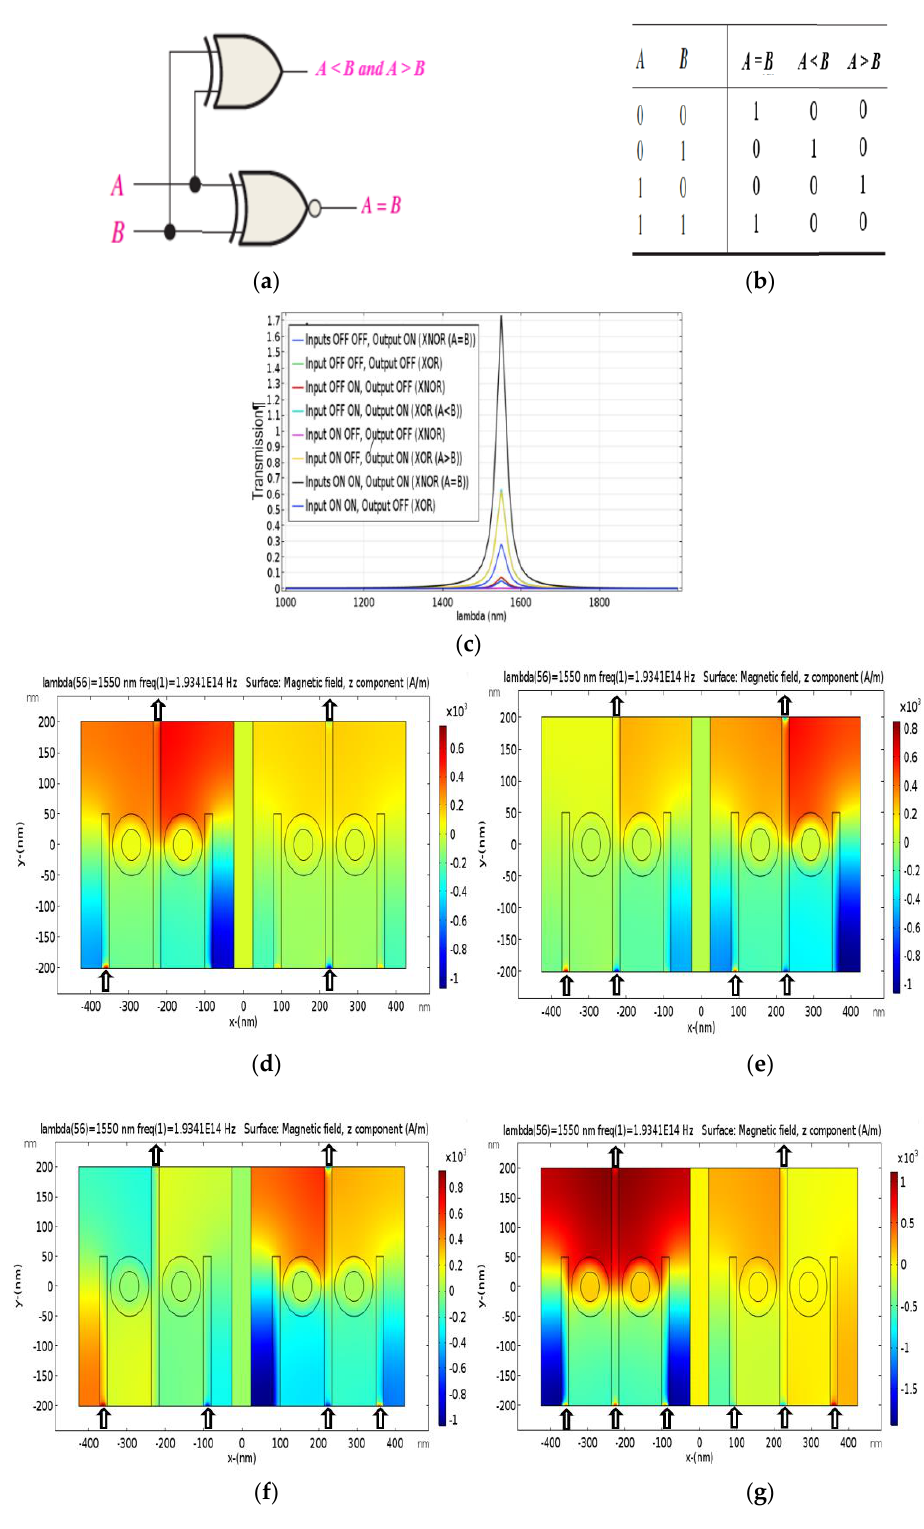
Figure 4. ( a ) and ( b ) the conventional comparator one-bit logic diagram and its truth table, respectively. ( c ) The transmission spectrum of the proposed plasmonic comparator one-bit for different states, according to its truth table. ( d ), ( e ), ( f ) and ( g ) the magnetic field distribution of Logic 00, 01, 10, and 11 inputs, respectively.